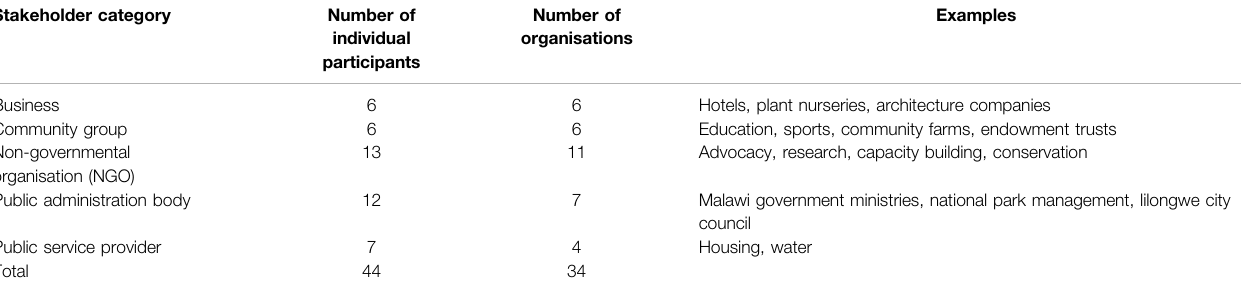
TABLE 1 | Number of participants, organisations and examples of organisation types for each stakeholder